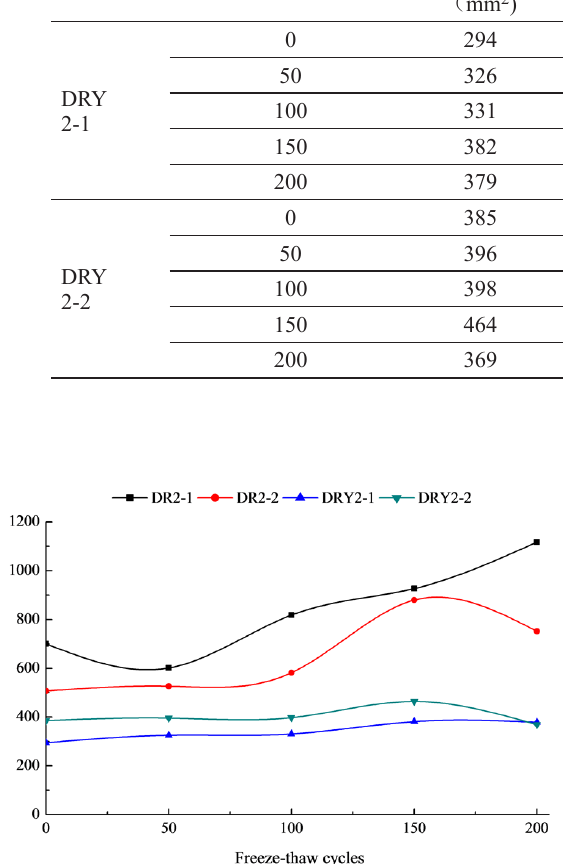
Table 2. Pore size distributions in the shotcrete specimens mixed with the air-entraining agent after different numbers of freeze-thaw cycles Specimen No.